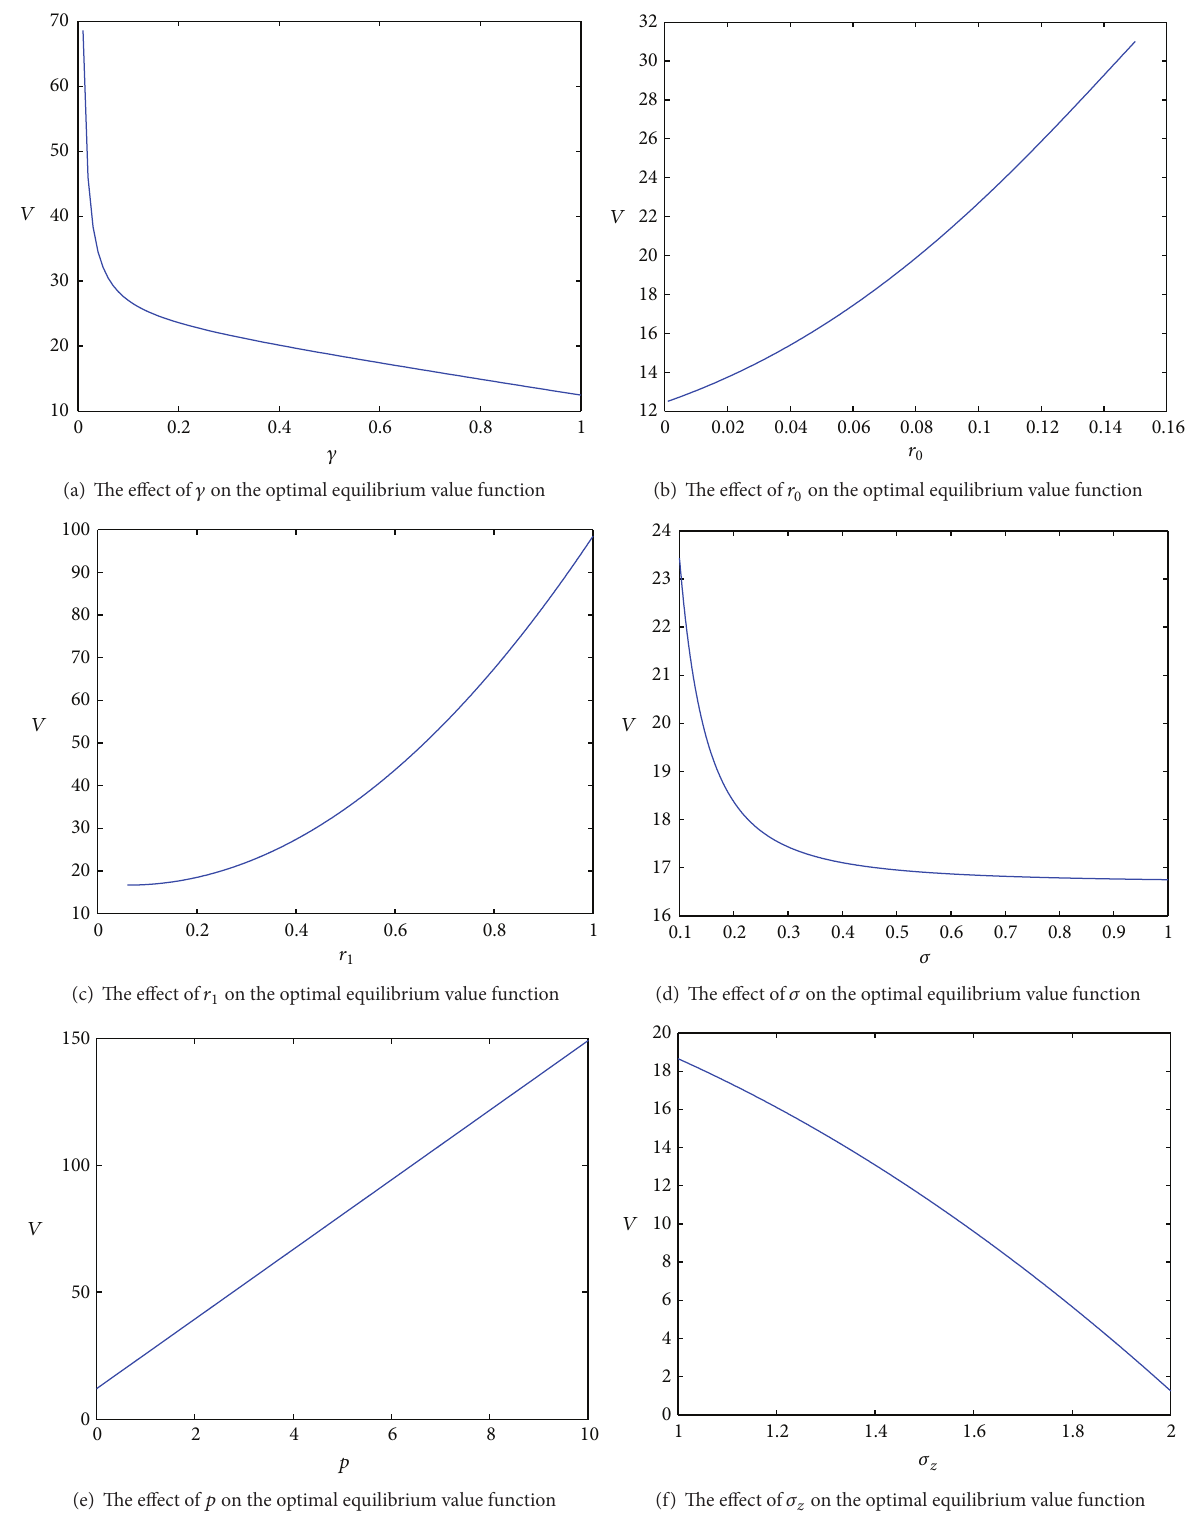
Figure 5: The effect of parameters on the optimal equilibrium value